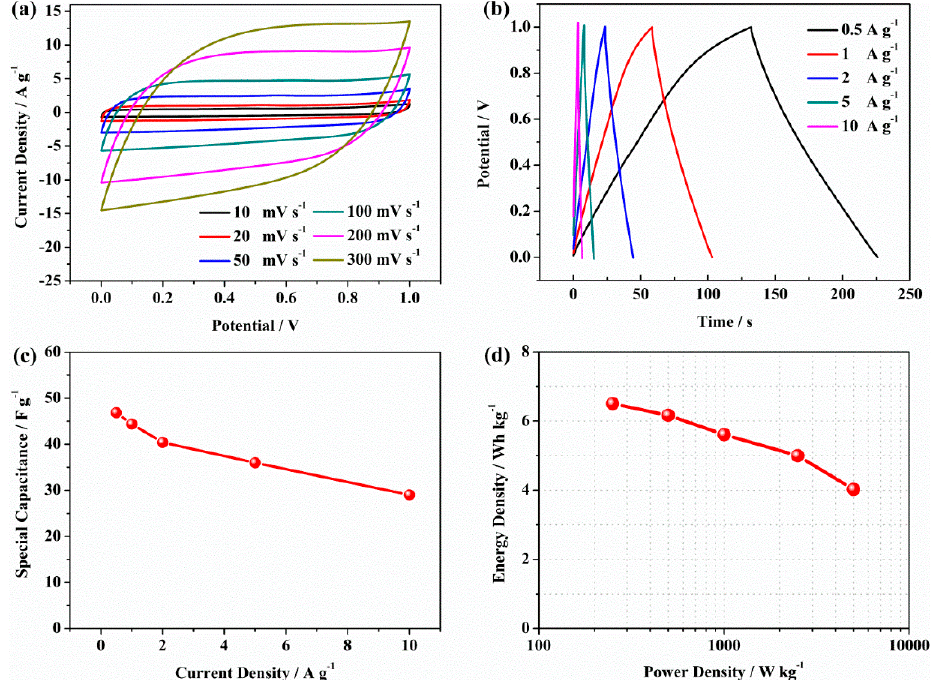
Figure 10. Electrochemical performances of the KAC-800 symmetric cell measured in 6 M potassium hydroxide (KOH) electrolyte: ( a ) CV curves at different scan rate; ( b ) GCD curves at various current densities; ( c ) capacitances of KAC-800 electrode at various current densities; ( d ) Ragone plot of KAC- 800.